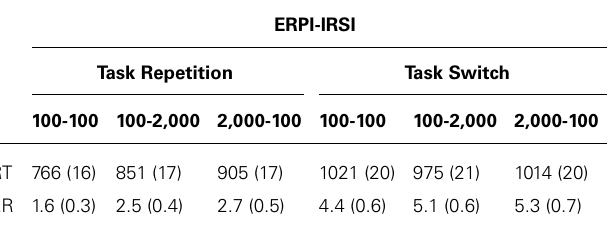
Table 3 | Mean task execution RTs and ERs of the restricted/repetition-possible condition as a function of ERPI-IRSI combination andTaskTransition (SEM in